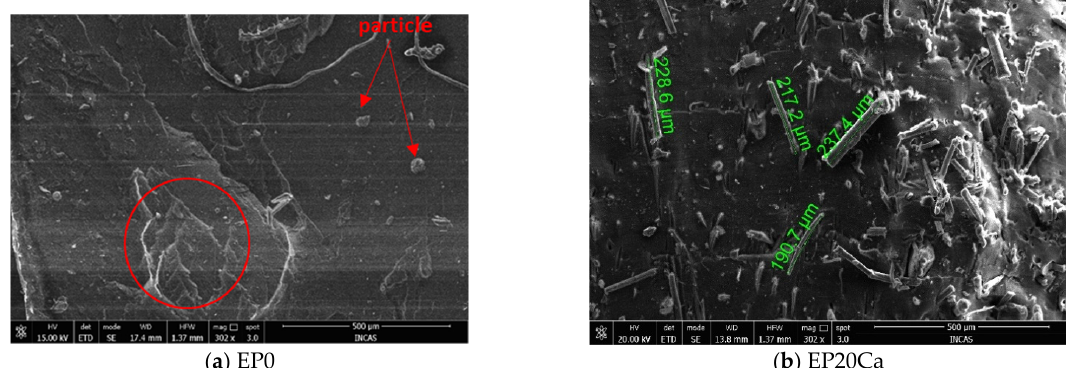
Figure 6. SEM micrographs of EPDM/hemp fiber composites ( a ) EP0 and ( b ) EP20Ca.